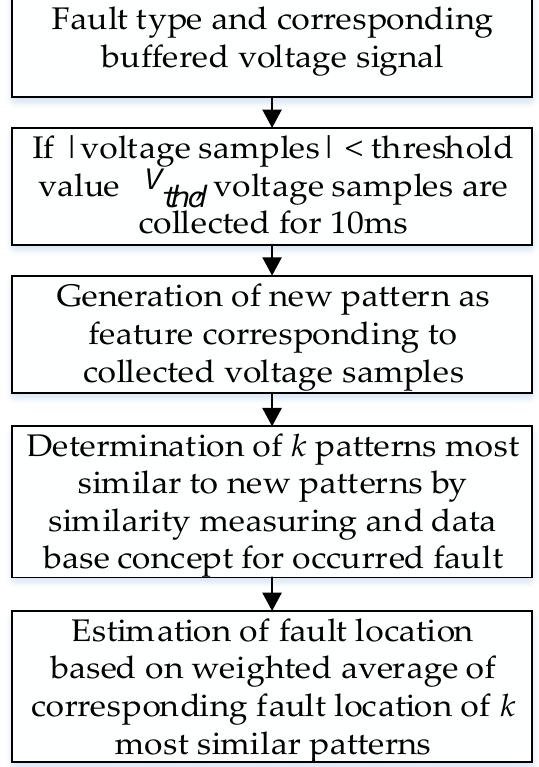
Figure 9. Fault location algorithm based on voltage similarity signals.